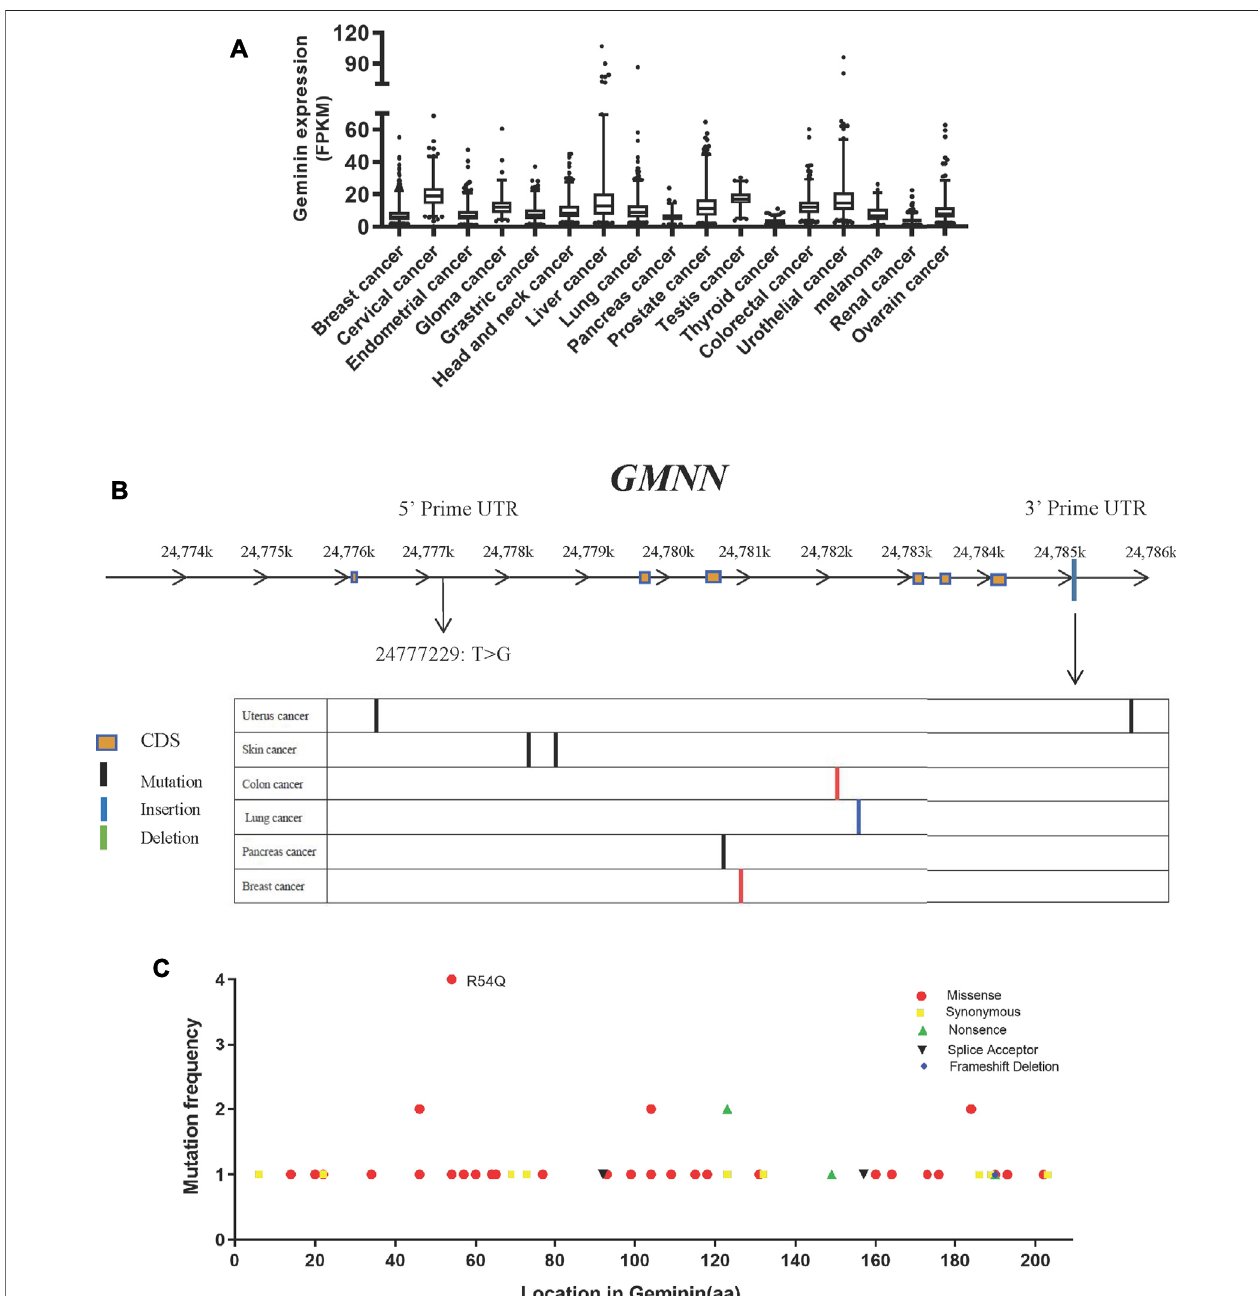
FIGURE 1 | Mutation of geminin is non-predominant in human cancer. (A) RNA expression of geminin in 17 cancer types. (B) Location of mutation sites in GMNN gene. (C) Summary of geminin mutations across different tumor types from TCGA.